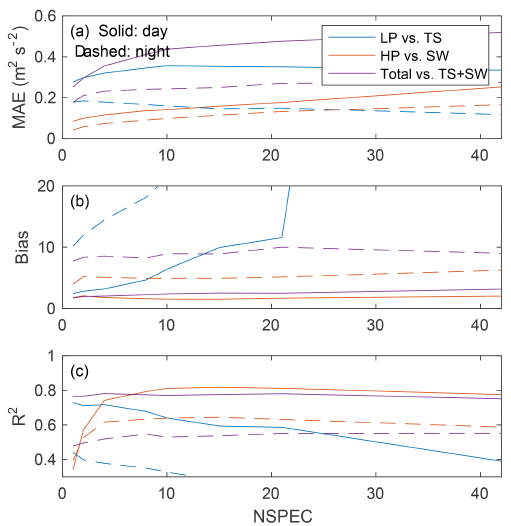
Figure 8. Same as in Fig. 6 but separated by daytime (solid lines) and nighttime (dashed